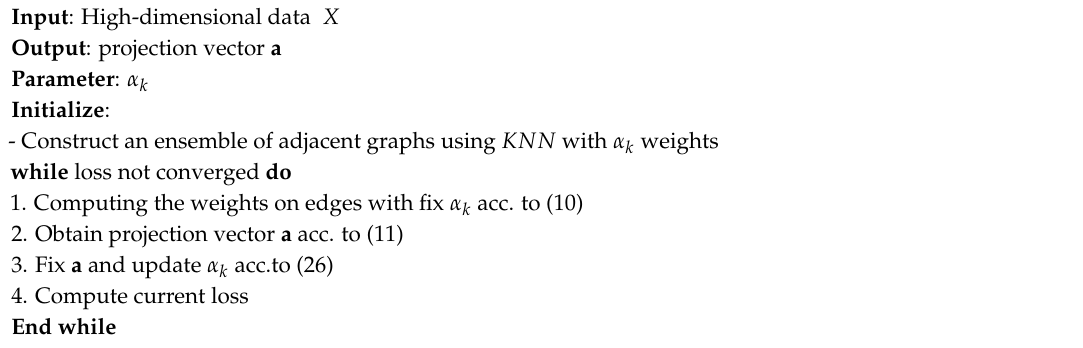
Algorithm 1. The weighted neighborhood preserving ensemble embedding